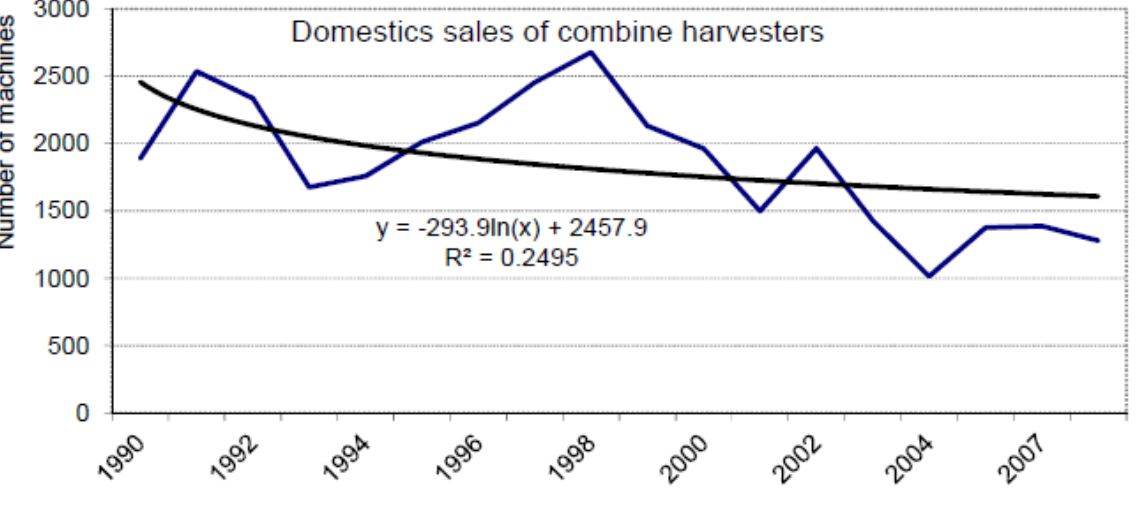
Figure 2. Domestic sales of combine harvesters in Germany (1990–2008) (own calculations based on